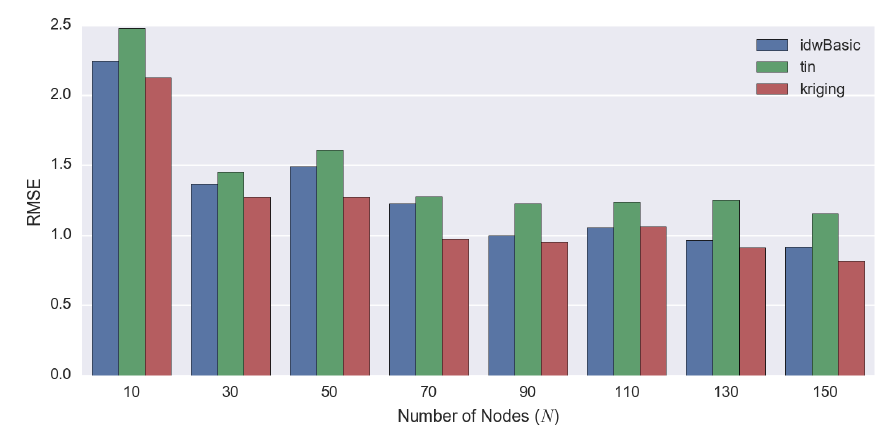
Figure 9. This graph demonstrates the quantitative comparisons (RMSE) between the different 2D spatial interpolation techniques, using the data as shown in Table 4.